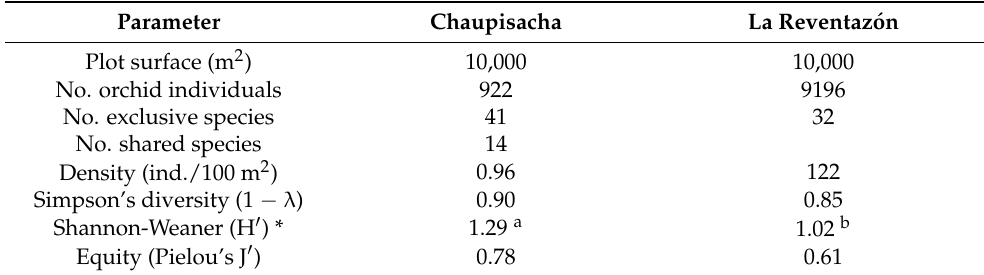
Table 1. Plot surface, richness, orchid density, and diversity indices in two forests on the Pululahua Geobotanical Reserve, Pichincha province, Ecuador. Parameter Chaupisacha La Reventaz ó n Plot surface (m 2 ) 10,000 10,000 No. orchid individuals 922 9196 No. exclusive species 41 32 14 0.96 122